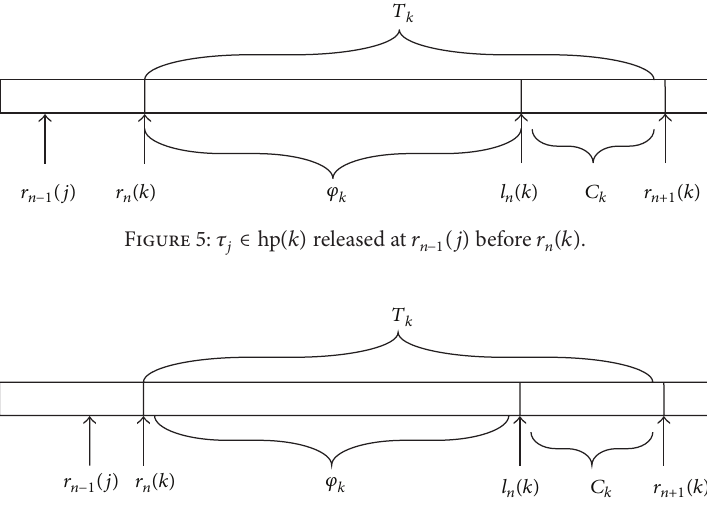
Figure 6: 𝜏 𝑗 ∈ lp (𝑘) released in 𝑟 𝑛−1 (𝑗) before 𝑟 𝑛 (𝑘) .